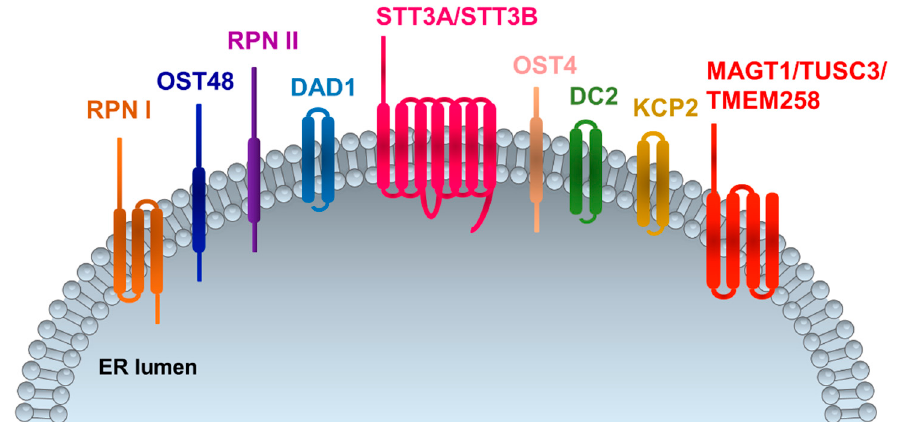
Figure 1. Oligosaccharyltransferase (OST) complex subunits in mammalians. RPNI and RPNII: ribophorin I and II; OST4 and OST48: oligosaccharyltransferase 4 and 48; DAD1: defender against cell death 1; STT3A and STT3B: oligosaccharyltransferase complex catalytic subunit A and B; DC2: oligosaccharyltransferase complex non-catalytic subunit; KCP2: keratinocyte-associated protein 2; MAGT1: magnesium transporter 1; TUSC3: tumor suppressor candidate 3; TMEM258: transmembrane protein 258. ER: endoplasmic reticulum.